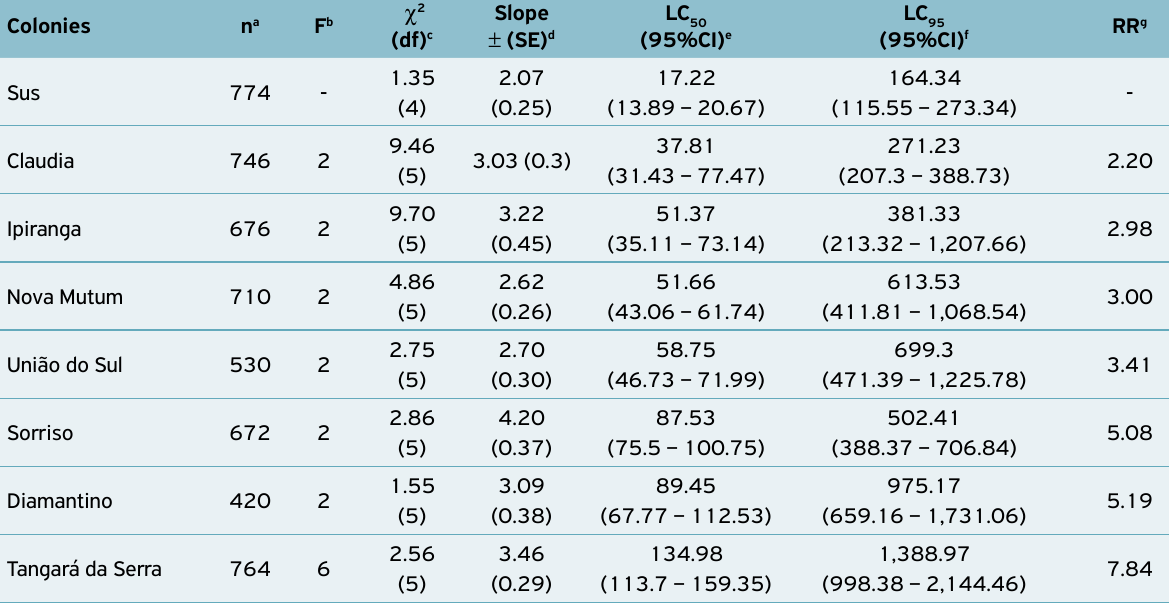
Table 5. Susceptibility of C. includens populations to spinosad.